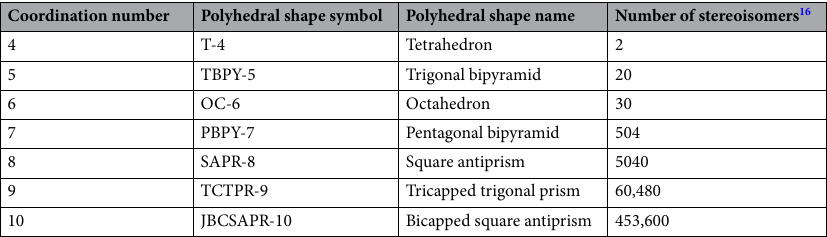
Table 1. Numbers of stereoisomers (all chiral) for metallic complexes with all different monodentate ligands, of coordination numbers, CNs, from 4 to 10, for prevalent polyhedral